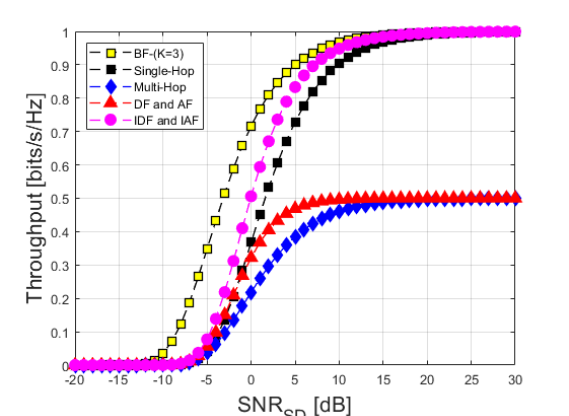
Figure 11. Throughput vs. SNR.